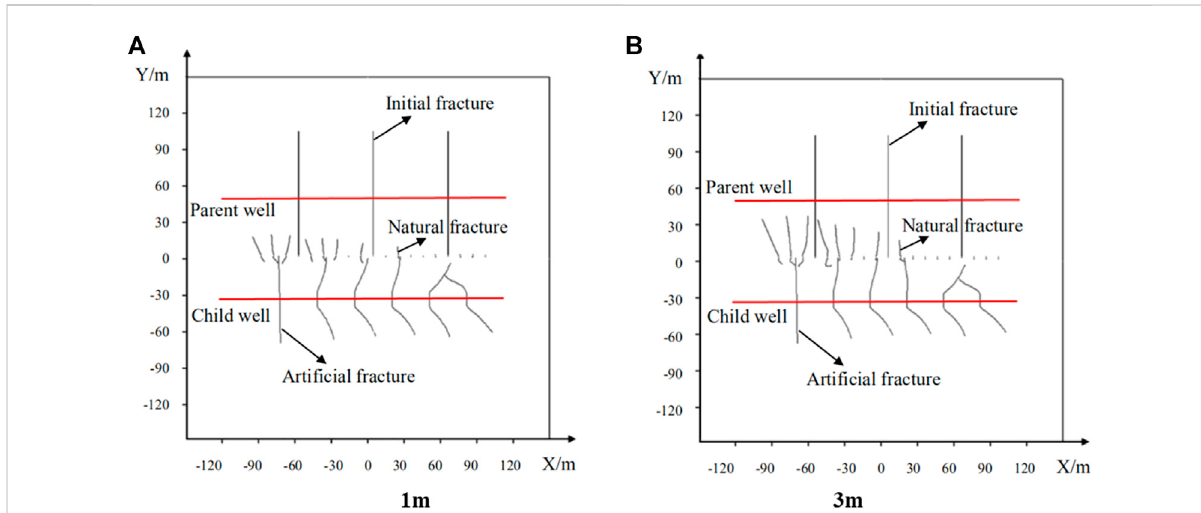
FIGURE 15 Fracture propagation trajectories under different initial lengths of natural fractures.